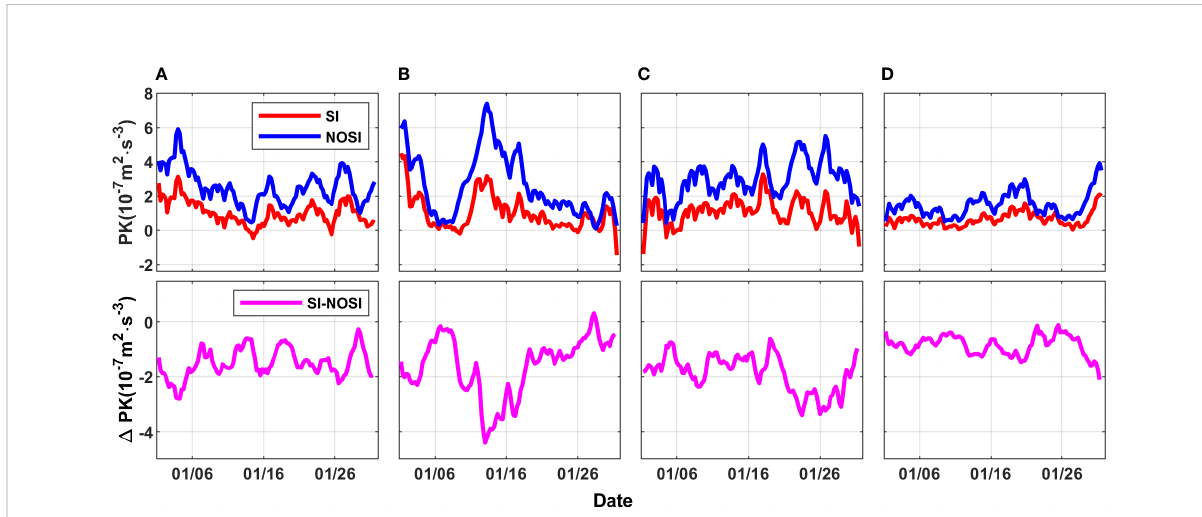
FIGURE 9 The time series of the PK and PK difference of two cases in the upper 30 m in January (A) 2017, (B) 2018, (C) 2019, (D) 2020. PK, the rate of the energy release of larger scale APE to the submesoscale via buoyancy